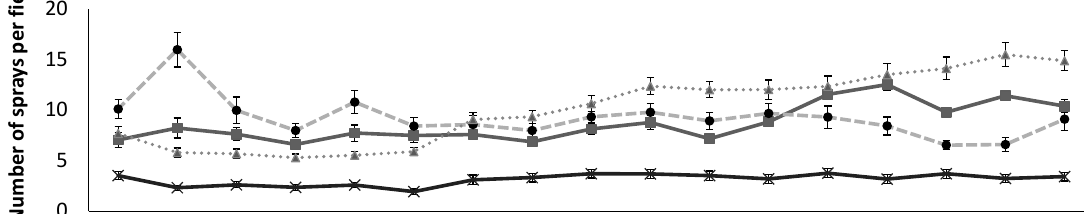
Fig. 2. PPP application frequency per active ingredient per field (number of sprays per field) on potato, swede, carrot and pea crops in 2003–2019. Note that several different PPPs could be sprayed simultaneously as tank mixes when this was appropriate; each a.i. in such cases is considered as one